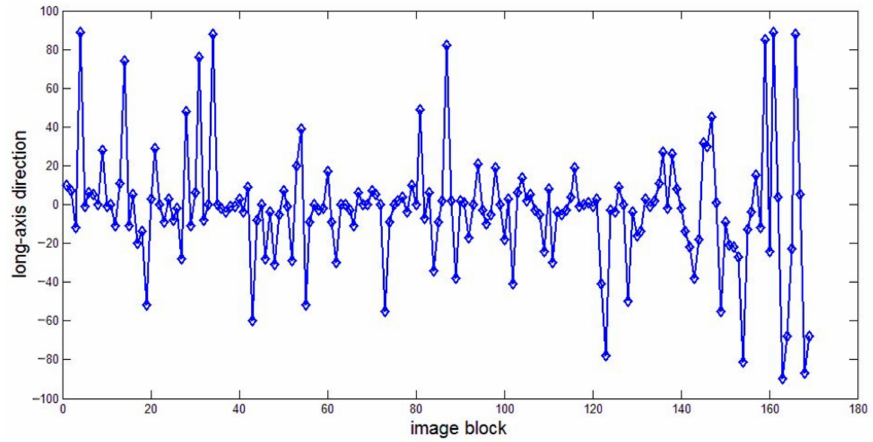
Figure 3. Long-axis directions of the